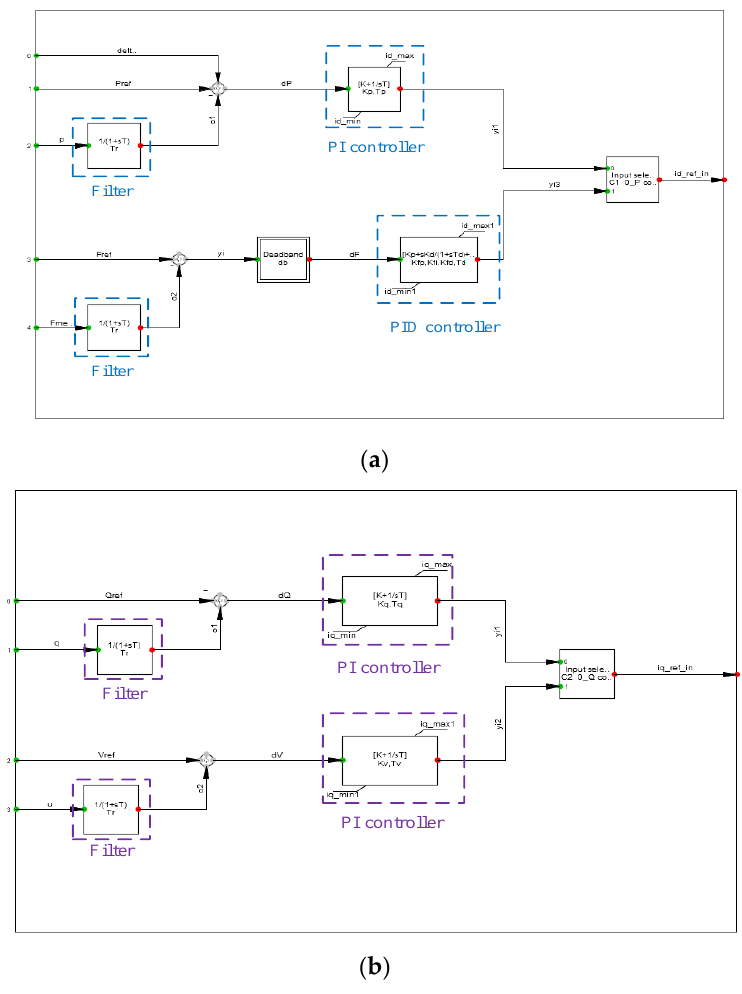
Figure 8. Common model diagram of BESS with ( a ) Pf controller; ( b ) QV controller.